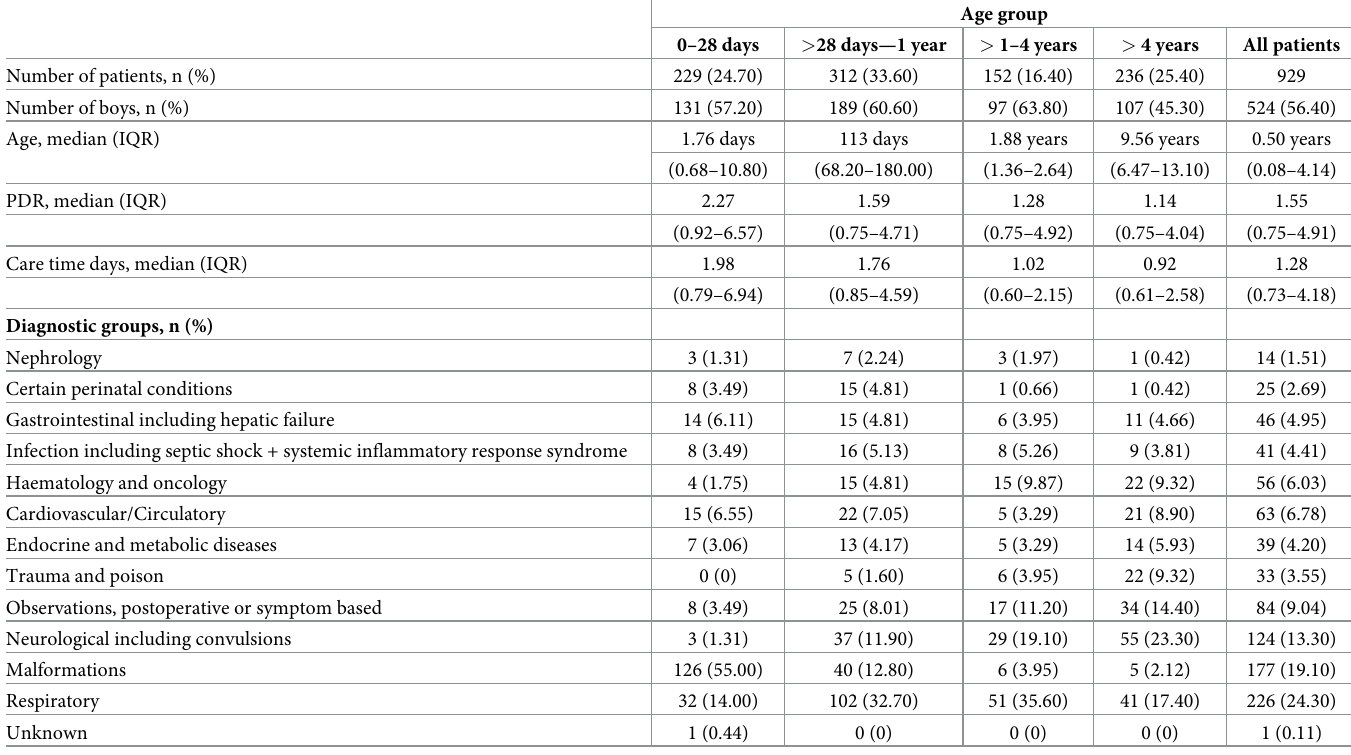
Table 2. Patient characteristics and PICU admission diagnosis by age groups: Patients with repeated admissions: First admission.